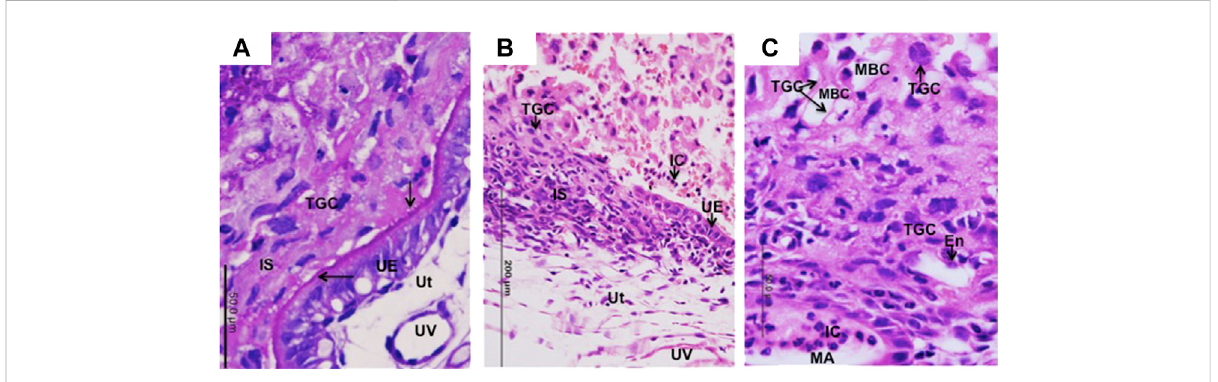
FIGURE 4 Migration of TGCs in Necromys lasiurus . (A – C) Early contact (day 10) between trophoblast giant cells (TGC) and uterine tissues (Ut) at the implantationsite(IS). (A) PAS-positivereactionintheapicalsurfaceofintactuterineepithelium(UE).Notetheinitialestablishmentofcontact(arrows) between trophoblast giant cells (TGCs) and uterine epithelium (UE). UV = uterine vessels. Periodic acid-Schiff. (B) A region still with some intact uterine epithelium (UE) with invasive TGCS (to the side or below). IC = in fl ammatory cells. Haematoxylin and eosin. (C) Trophoblast giant cells (TGCs)liningthematernalbloodchannels(MBC).Notethemigrationoftrophoblastgiantcells(TGCs)intomaternal tissuesassociatedwithmaternal vessel endothelium (En) and in fl ammatory cells (IC) within maternal artery (MA). Haematoxylin and